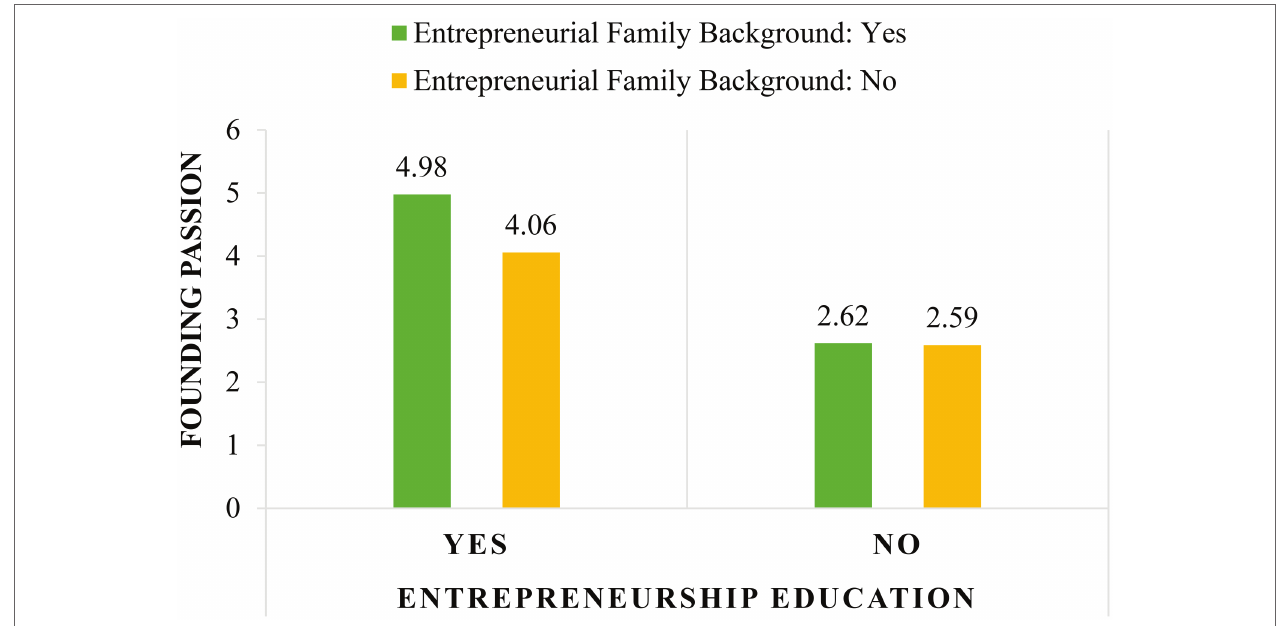
FIGURE 2 | The moderation effect of entrepreneurial family background on the relationship between entrepreneurship education and founding